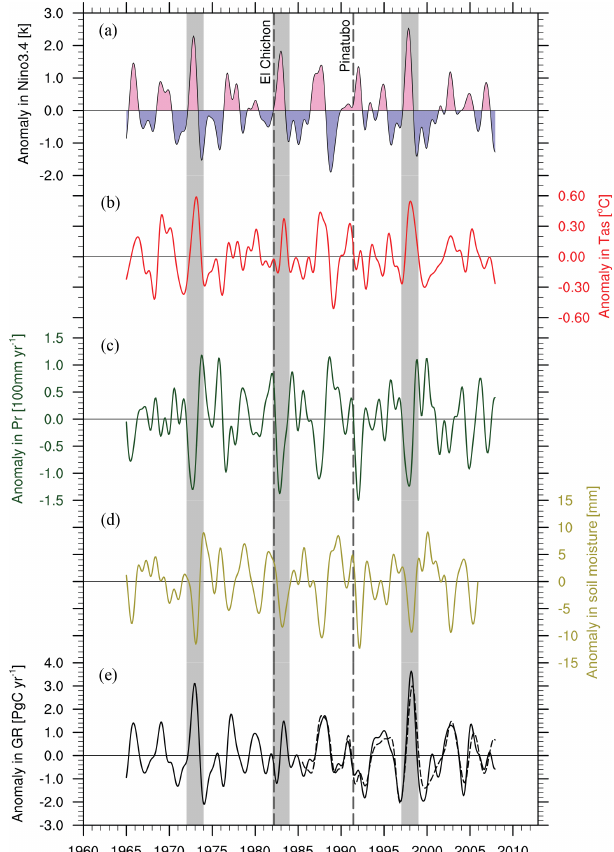
Figure 2. Interannual variabilities (IAVs) in the Niño 3.4 index, tropical land surface air temperature, precipitation, and soil mois- ture, and atmospheric CO 2 growth rate (CGR). The soil moisture was calculated from the surface layer to a 2m depth. The atmo- spheric CGR, for the Scripps Mauna Loa CO 2 data from 1960 to 2012 (solid line) and the globally averaged marine surface CO 2 data from 1980 to 2012 (dashed line), are shown as the difference be- tween the monthly averaged concentrations in the adjacent 2years. The gray bars represent the three strongest El Niño events during 1965–1966, 1982–1983, and 1997–1998 years and vertical dashed lines show the eruptions of El Chichón and Mount Pinatubo volca- noes in 1982 and 1991, respectively.